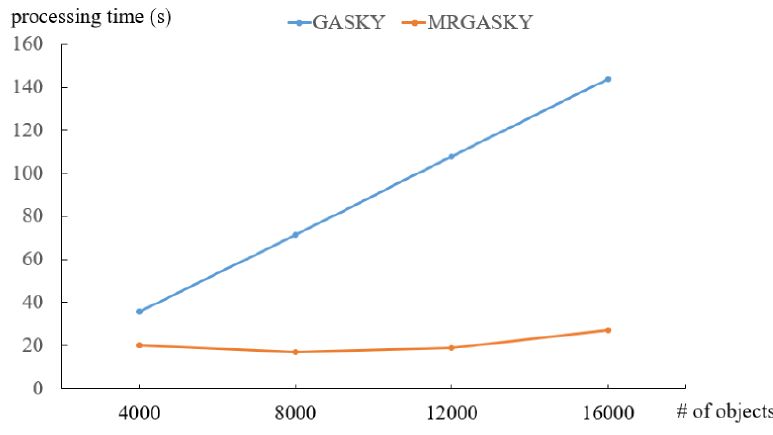
Figure 16. Processing Time of SYN_C.